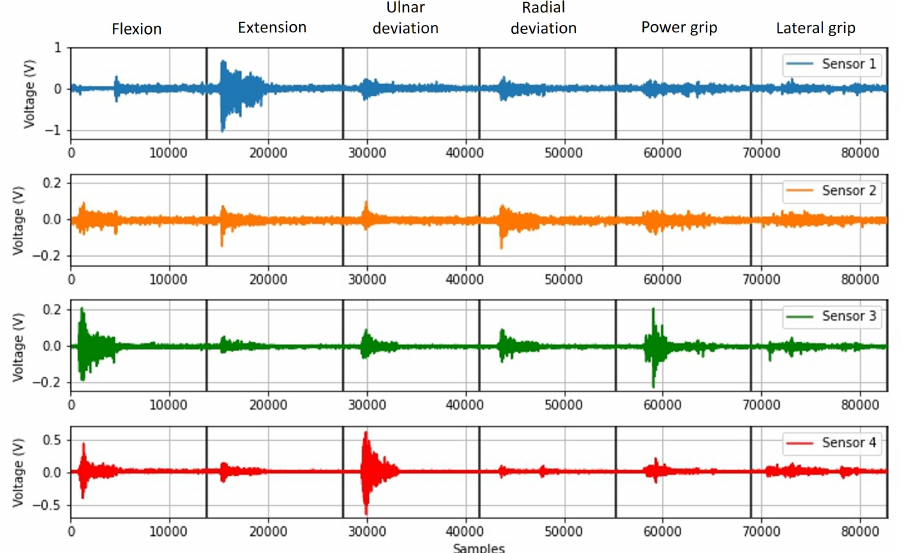
Figure 11. Signals obtained from each of the four sEMG sensors with the signal acquisition protocol.